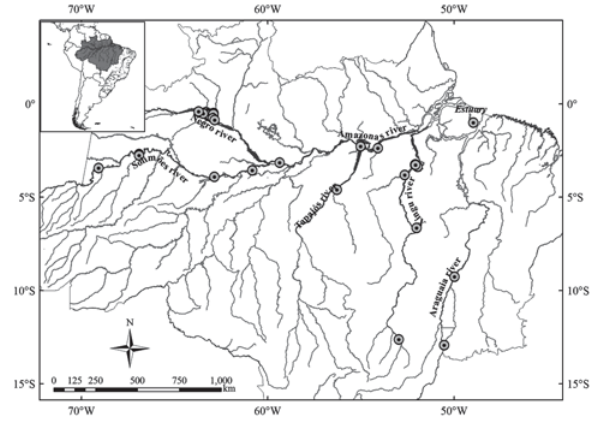
Fig 1. Map with the sample locations. In some localities more than one individual was